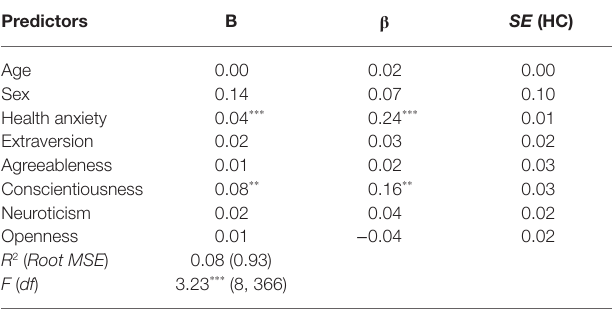
TABLE 4 | The characteristics of the multiple regression results.